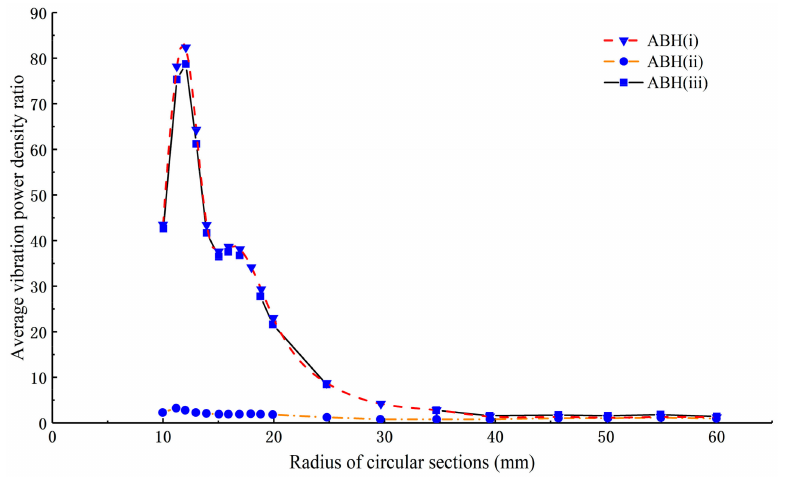
Figure 9. Average vibration power density ratios at excitation frequencies of 1050